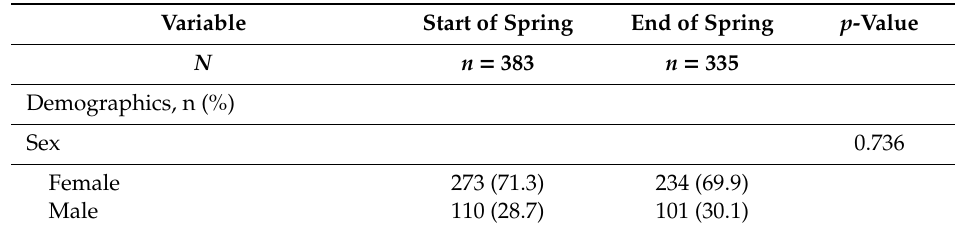
Table 2. Key demographics of students included in the longitudinal analyses examining the association of weight-related behavioral factors with BMI over time ( n =